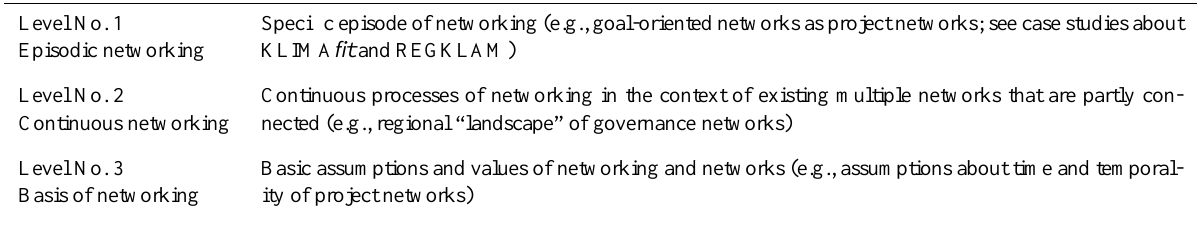
Table 2. Three levels of attention to analyze goal-oriented networks from a network management perspective (source: inspired by Weick and Quinn, 1999; Healey, 2007; Jones and Liechtenstein, 2008; Raab and Kenis,